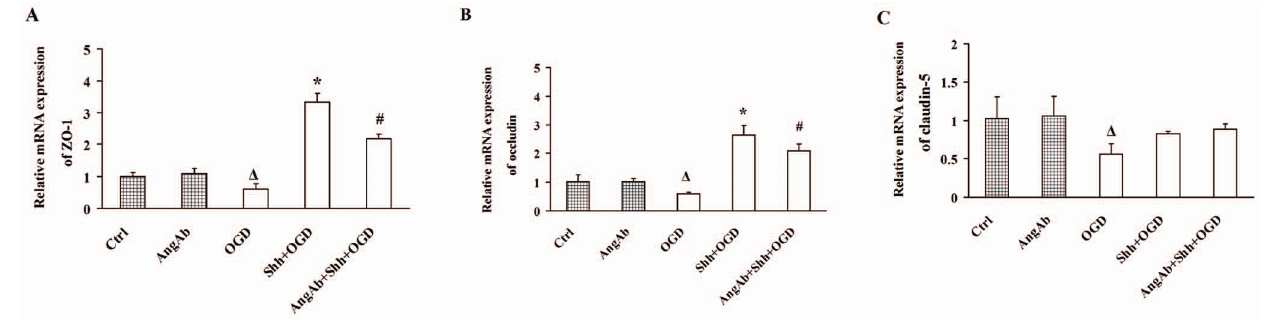
Figure 6. Treatment with Ang-1-neutralizing Antibody Suppresses Shh-up-regulated ZO-1 and Occludin in BMECs under OGD. BMECs were pre-treated with Ang-1-neutralizing antibody (AngAb), and/or PBS, Shh for 30 min, and then subjected to the OGD for 4 h. (A-C) The mRNA levels of ZO-1 (A), occludin (B) and claudin-5 (C) were determined by real-time RT-PCR. Ctrl: cells were pre-treated with PBS and then subjected to normal oxygen condition. AngAb: cells were pre-treated with AngAb and then subjected to normal oxygen condition. OGD: cells were pre-treated with PBS and then subjected to OGD. Shh + OGD: cells were pre-treated with Shh and then subjected to OGD. AngAb + Shh + OGD: cells were pre- treated with Shh plus AngAb and then subjected to OGD. D P , 0.01 vs. the Ctrl group, * P , 0.01 vs. the OGD group, # P , 0.01 vs. the Shh group. Each experiment was repeated three times (n=6, each group).